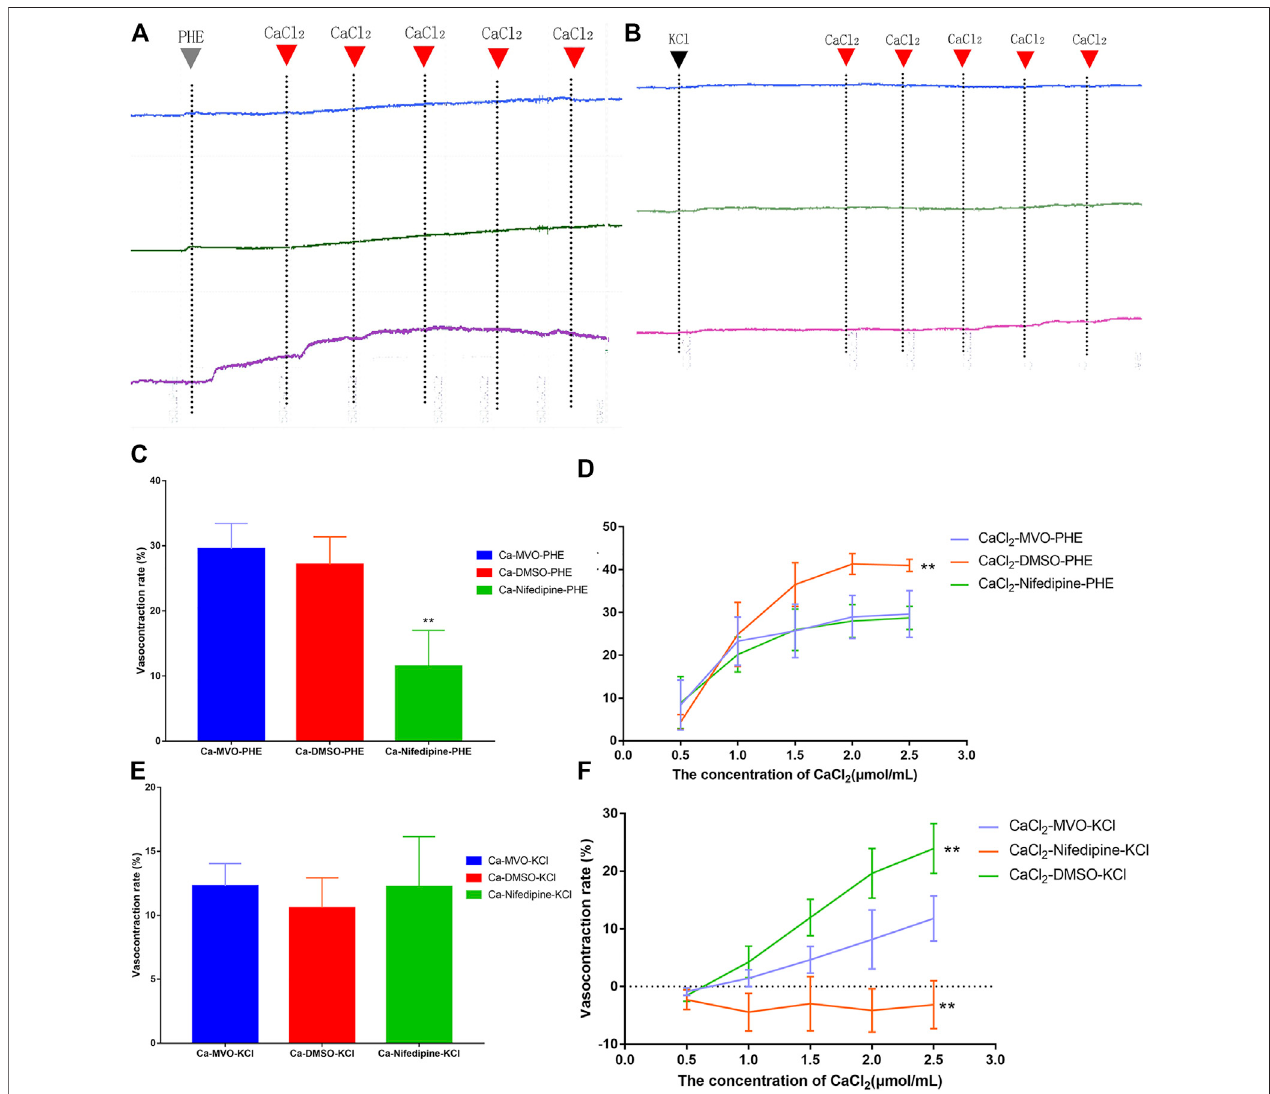
FIGURE 9 | The effect of calcium signaling pathway on vasorelaxation effect of MVO (4.5 μ g/ml, the blue line), nifedipine (4.5 μ M, the green line), and DMSO (0.015%(v/v),thepurpleline)onthe (A) PHE(10 μ M)or (B) KCl(60 mM)-inducedcontractionsof-EaorticringsinCa 2+ -freesolution.InhibitoryeffectsofMVO(4.5 μ g/ml) on the (C) PHE (10 μ M) or € KCl (60 mM)-induced contractions of -E aortic rings in Ca 2+ -free solution. n = 6. Means ± S.D. * p < 0.05, ** p < 0.01 vs. Ca-MVO-PHE/KCl group.InhibitoryeffectsofMVO(4.5 μ